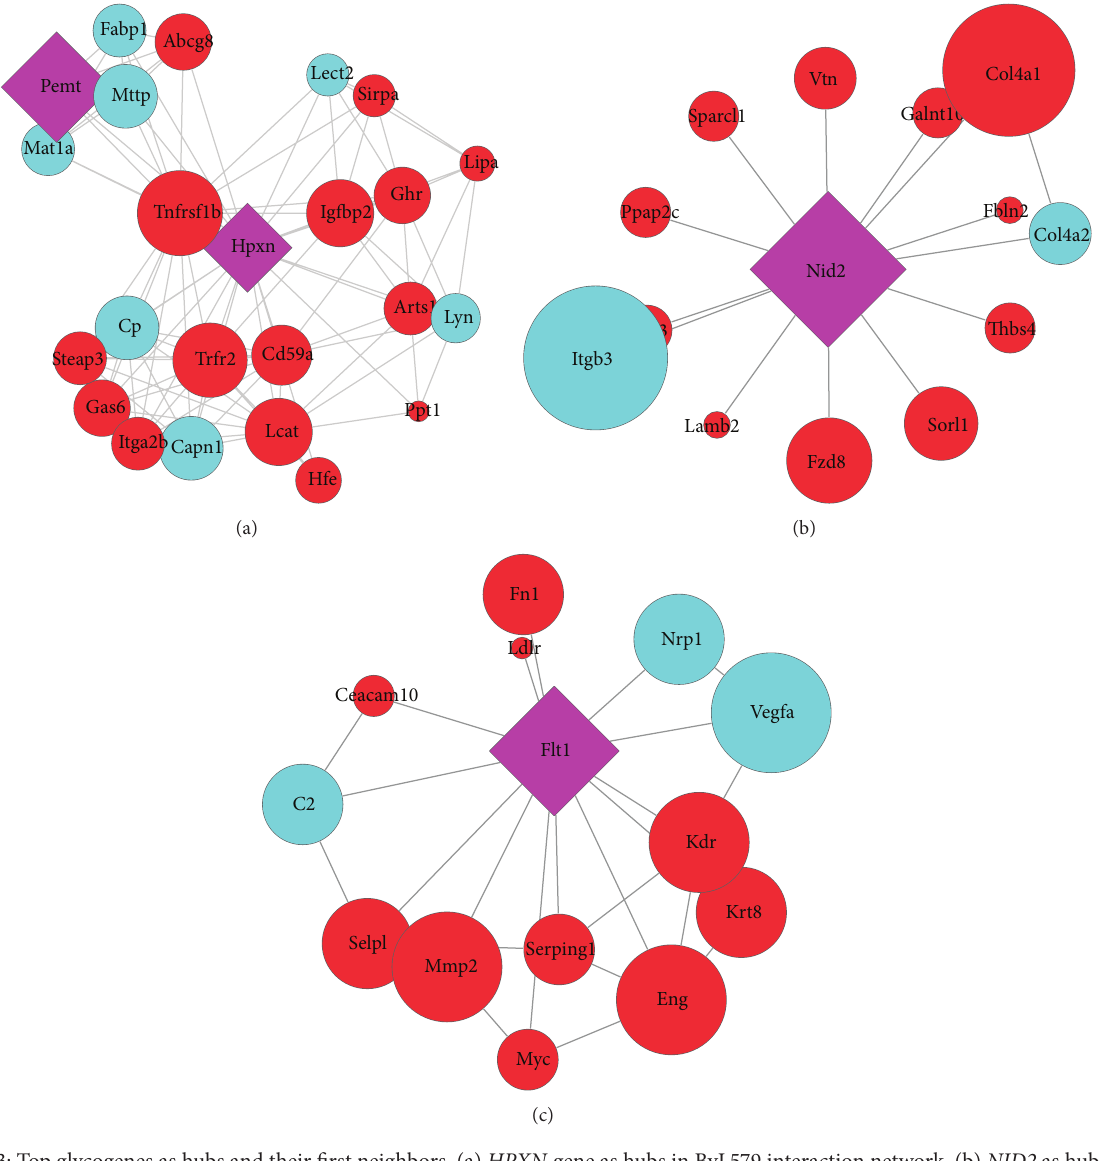
Figure 3: Top glycogenes as hubs and their first neighbors. (a) HPXN gene as hubs in BvL579 interaction network. (b) NID2 as hub gene in BvM501 interaction network. (c) FLT1 gene as hub in LvM442 interaction